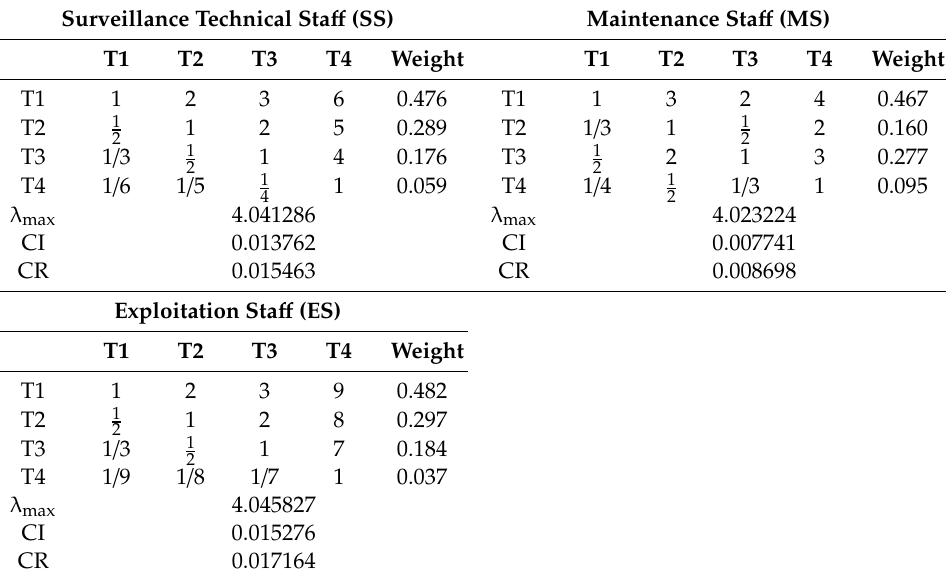
Table 14. Results of the pair-wise comparison of survey sub-criteria: Surveillance technical sta ff (SS), maintenance sta ff (MS), exploitation sta ff (ES).